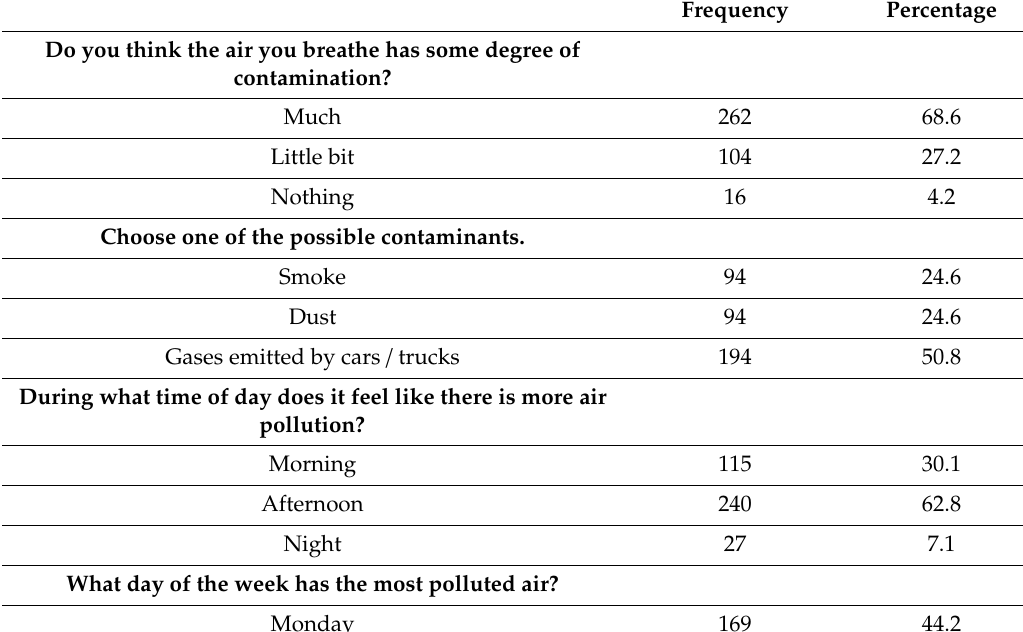
Table 8. Perception of air